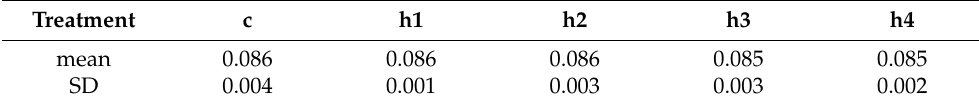
Table 1. Biomass (g FW) of Lemna minor in control and treatments at the beginning of the experiment. Treatment